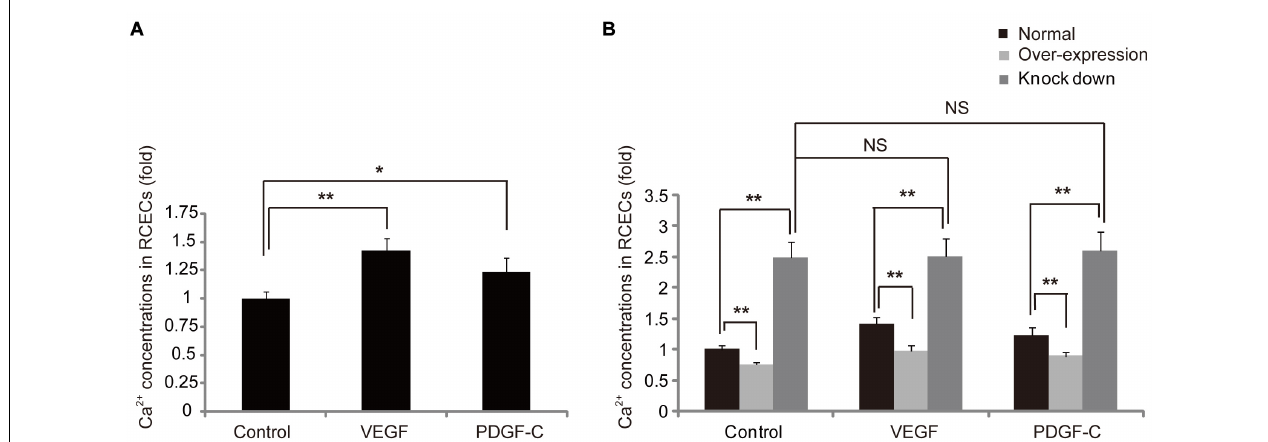
FIGURE 3 | JAM-C decreases cytosolic Ca 2 + concentrations in human RCECs. Cultured human RCECs were treated with VEGF (10 ng/mL) or PDGF-C (125 ng/mL) for 1 h. Cytosolic Ca 2 + concentrations were detected by flow cytometry. (A) VEGF and PDGF-C increased cytosolic Ca 2 + concentrations in RCECs. (B) JAM-C overexpression decreased cytosolic Ca 2 + concentrations, whereas JAM-C knockdown increased Ca 2 + concentrations in RCECs. VEGF and PDGF-C did not increase calcium influx in RCECs after JAM-C knockdown. * P < 0.05, ** P < 0.01, NS, not significant.